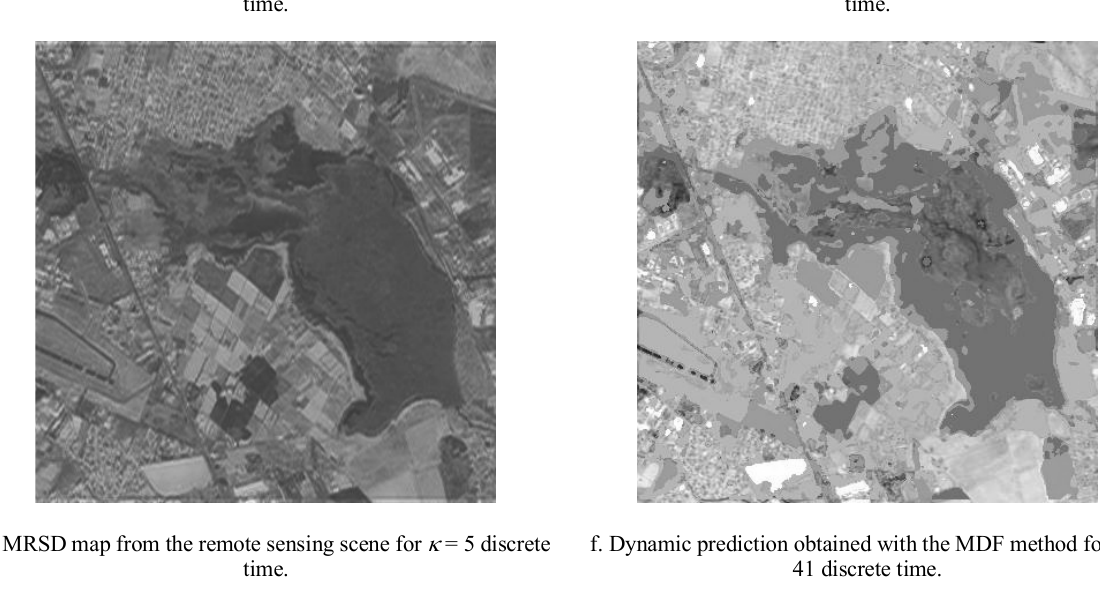
Figure 3. Simulation results for dynamic MRSD map